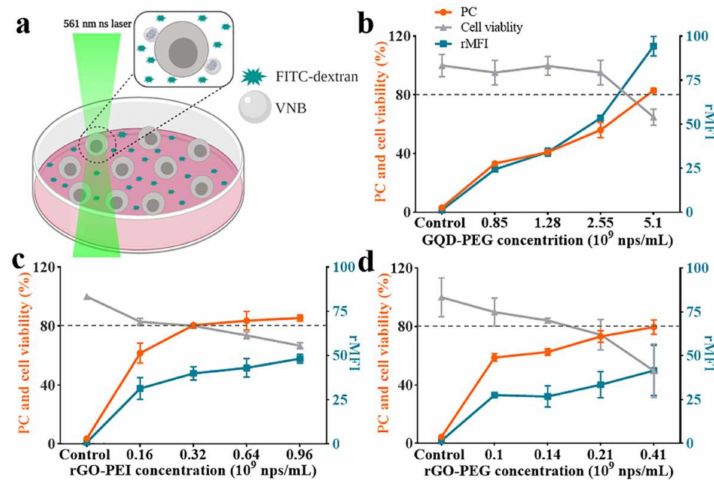
Figure 4. FD10 delivered into Jurkat cells by photoporation with polymer-modified graphene-based materials. ( a ) Conceptual illustration of the photoporation experiment. Created with